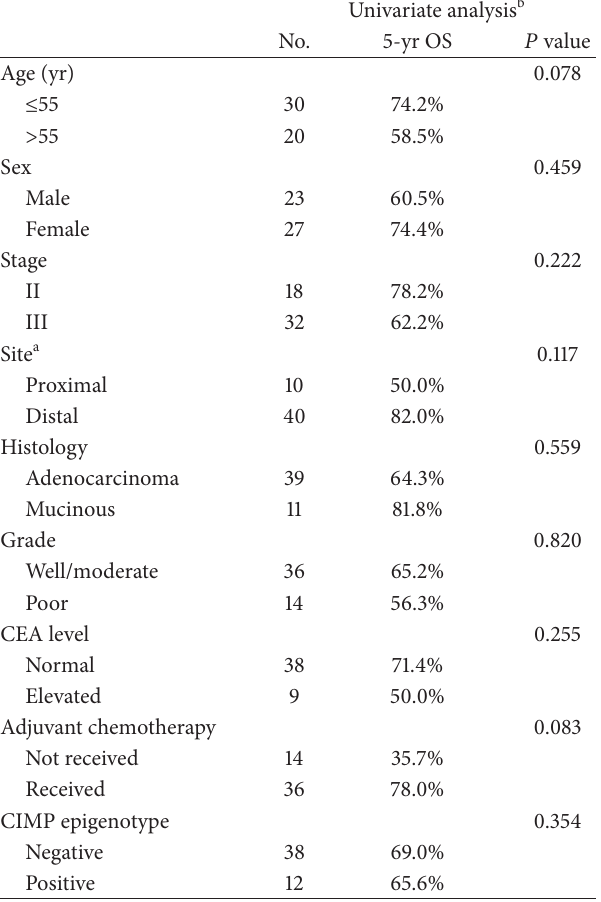
Table 3: Univariate analysis of the prognostic effect of CIMP status and clinicopathological features in stage II/III cases for